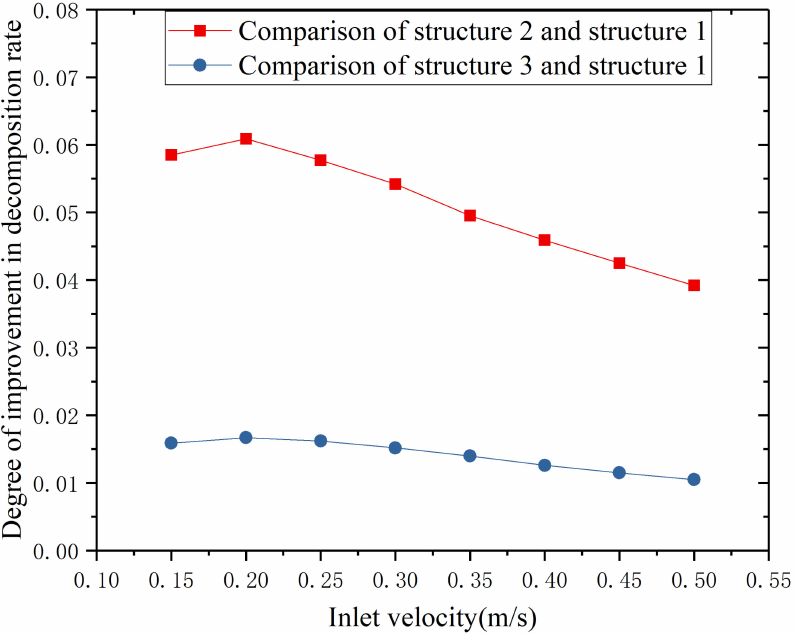
Figure 13. Comparison of improvements in the decomposition rates at varying flow